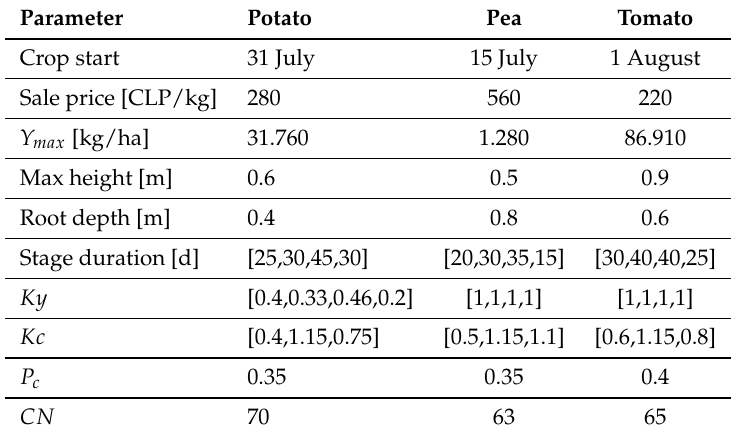
Figure 4. Topology of the proposed microgrid. Table 1. Crop characteristics.